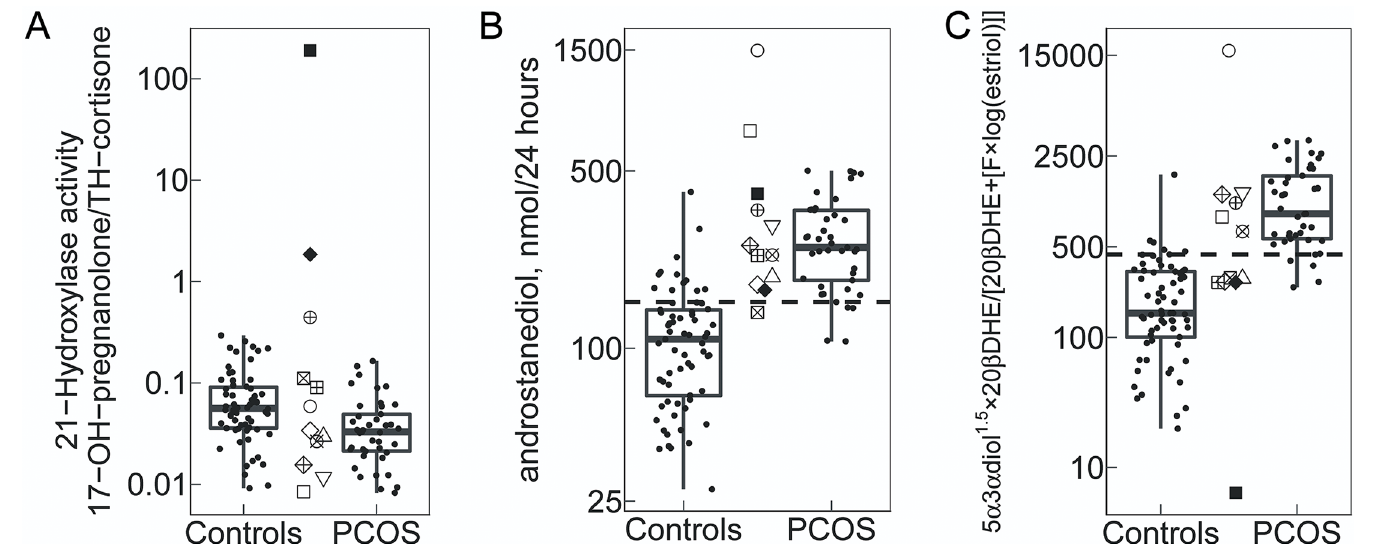
Fig 3. Prospective evaluation of PCOS classifiers. Black points scattered within the boxplots represent study participants. The ten not-filled point symbols between the boxplots represent urine profiles from suspected PCOS women, which were sent to our lab for excluding hyperandrogenism due to 21-hydroxylase deficiency, while the two black-filled point symbols represent urine profiles from women with genetically confirmed 21-hydroxylase deficiency. The dashed horizontal lines indicate the diagnostic thresholds of PCOS classifiers. A. 21-hydroxylase activity. A higher ratio of 17-OH-pregnanolone/TH-cortisone indicates a lower 21-hydroxylase activity. B. Classifier androstanediol. C. Classifier (androstanediol1.5 × 20 β -DH-cortisone)/(20 β -DH-cortisone+[cortisol × log(estriol)]).